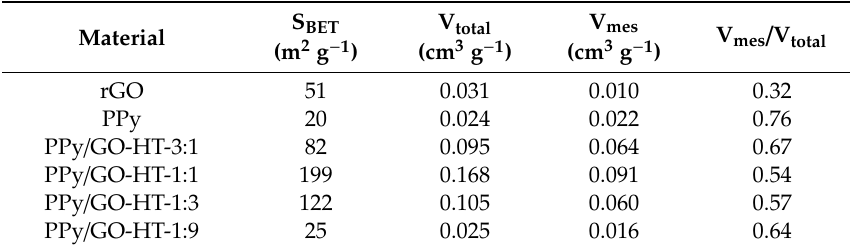
Figure 1. ( a ) N 2 sorption isotherms; ( b ) Quenched solid density functional theory (QSDFT) pore size distribution of reduced graphene oxide (rGO), polypyrrole (PPy) and polypyrrole / reduced graphene oxide (PPy / GO-HT) hybrids. Table 1. Textural parameters of rGO, PPy and the PPy / GO-HT hybrids obtained from the N 2 sorption analysis.